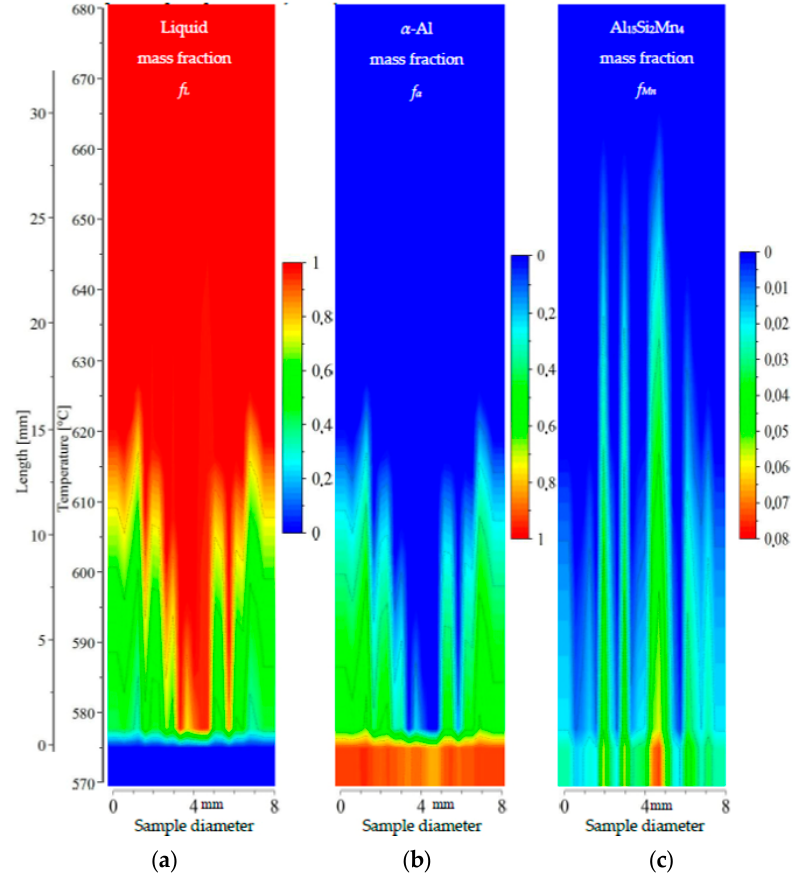
Figure 12. 2D maps of mushy zone for AlSi7Mn1.0 specimen: ( a ) liquid mass fraction f L ; ( b ) α -Al mass fraction f α ; ( c ) Al 15 Si 2 Mn 4 mass fraction f Mn in function of sample diameter and temperature/sample length.